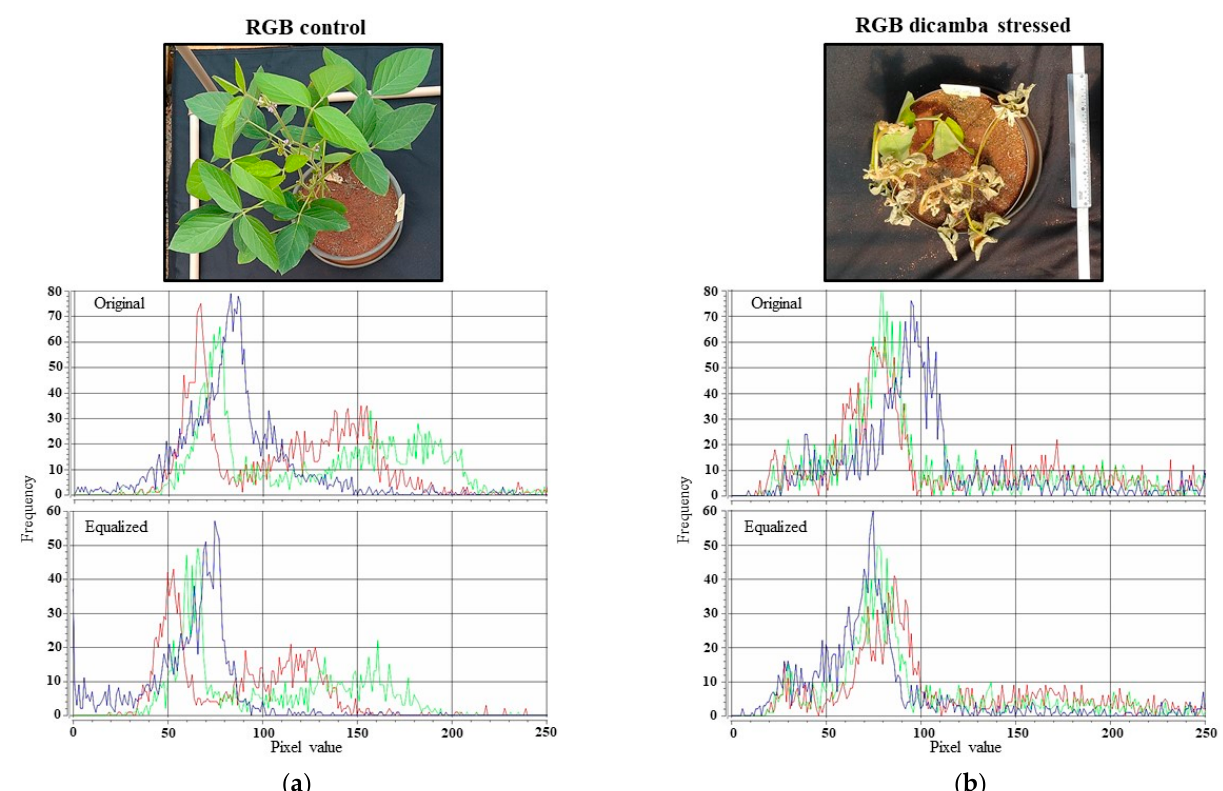
Figure 1. Equalized histogram of a RGD image of a control plant ( a ) and an injured plant ( b ) by simulated dicamba drift.